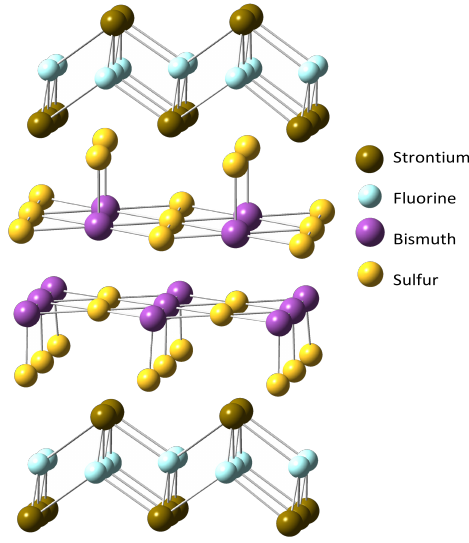
Figure 9: Crystal structure of SrFBiS 2